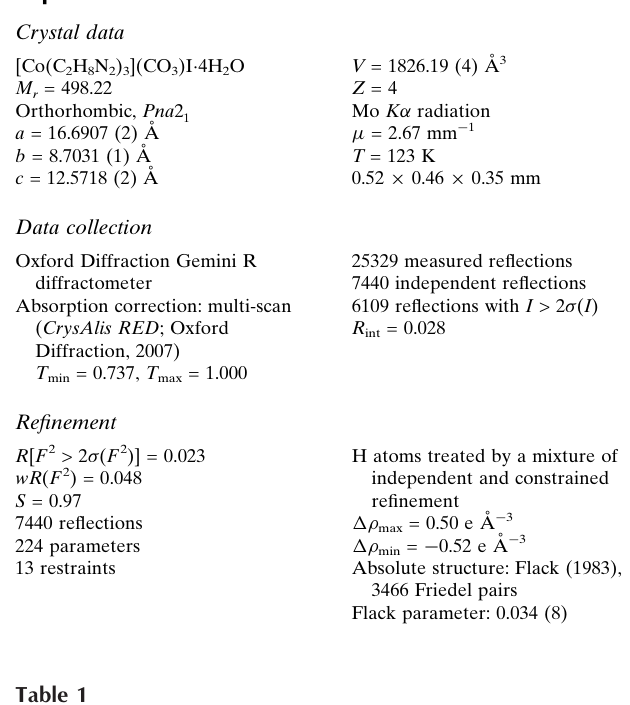
Hydrogen-bond geometry (A˚ , (cid:5)